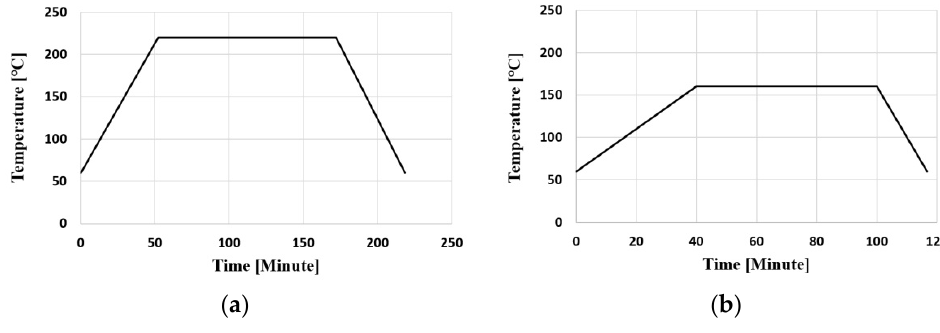
Figure 16. Laminating temperature as a function of time: ( a ) PPG; ( b ) SR.